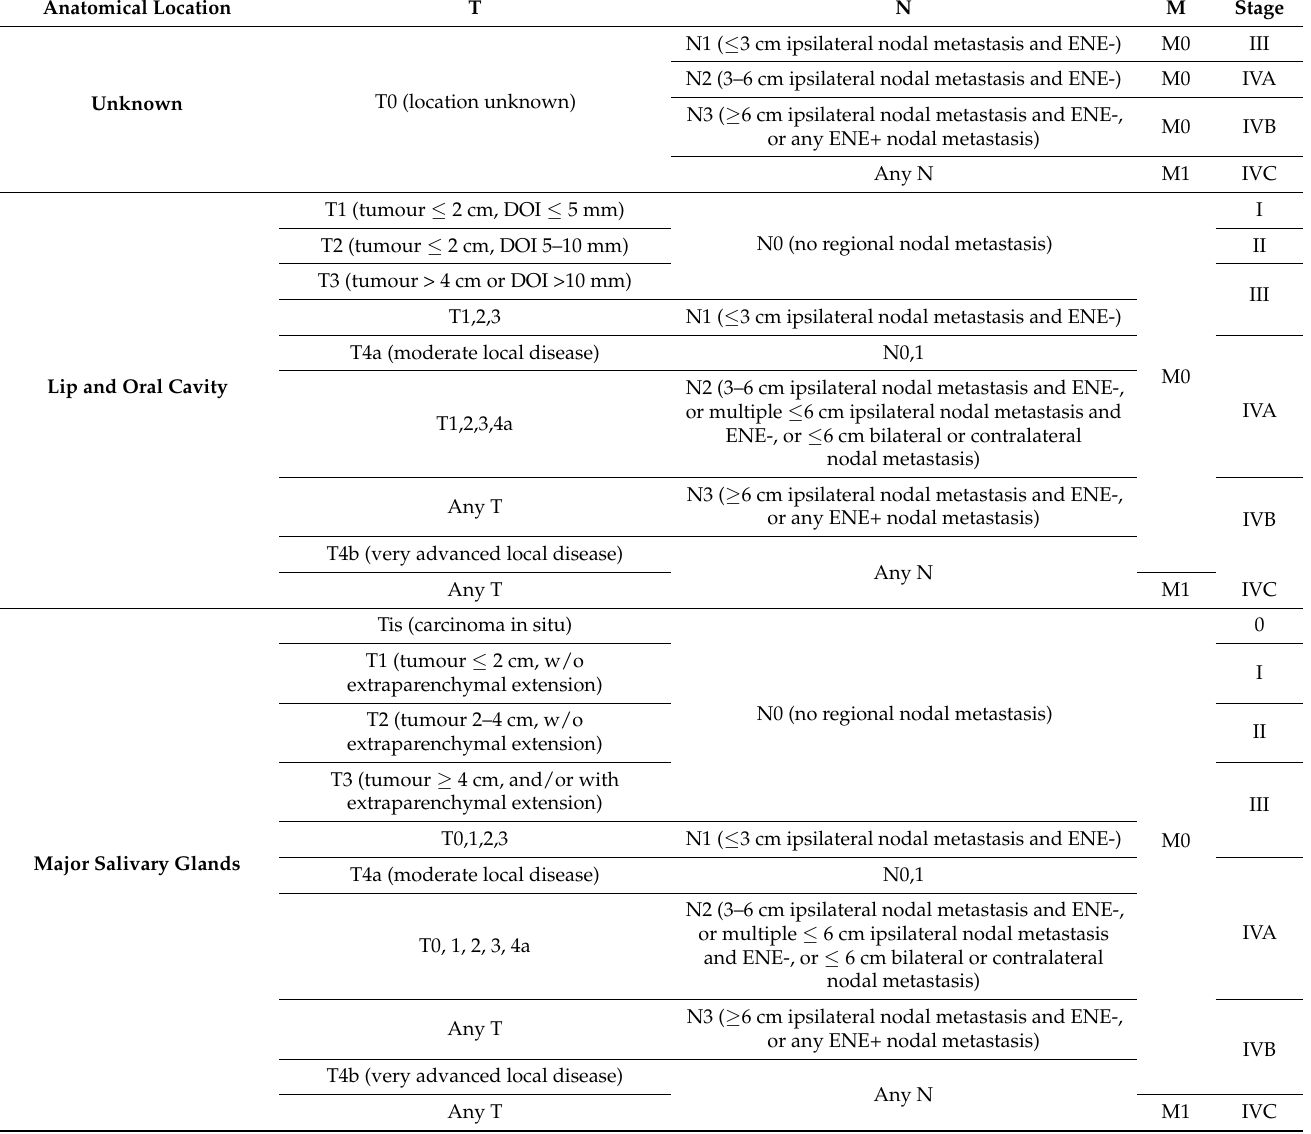
Table 2. TNM staging system of Head and Neck cancer (HNC) according to the 8th Edition of the American Joint Committee of Cancer (AJCC) Staging Manual (2017)